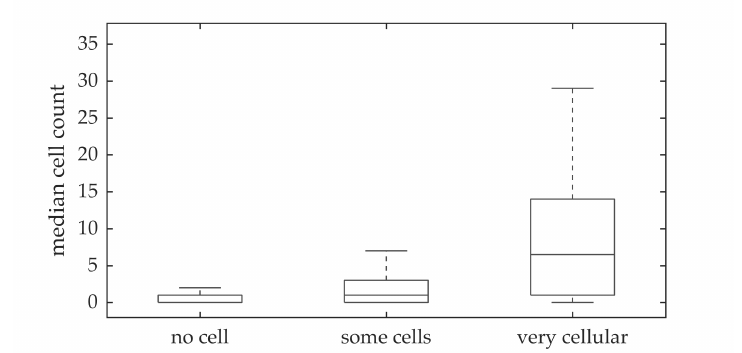
Figure 14. Comparison of median cell count against visual assessment of